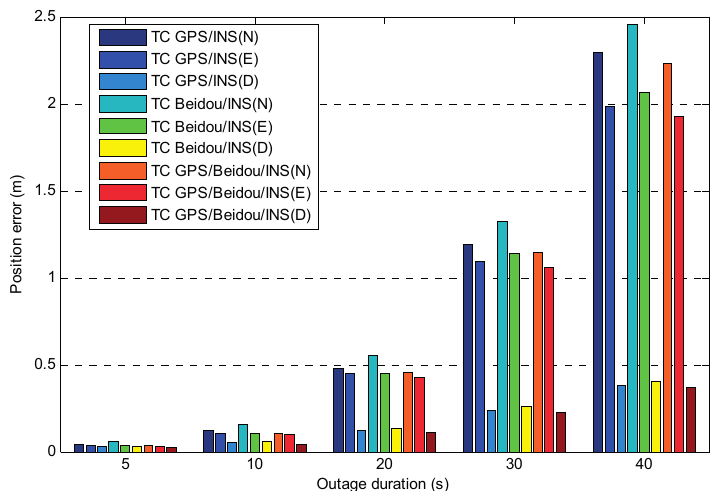
Figure 13. Average of the maximum position error vs. outage duration for different system configurations.